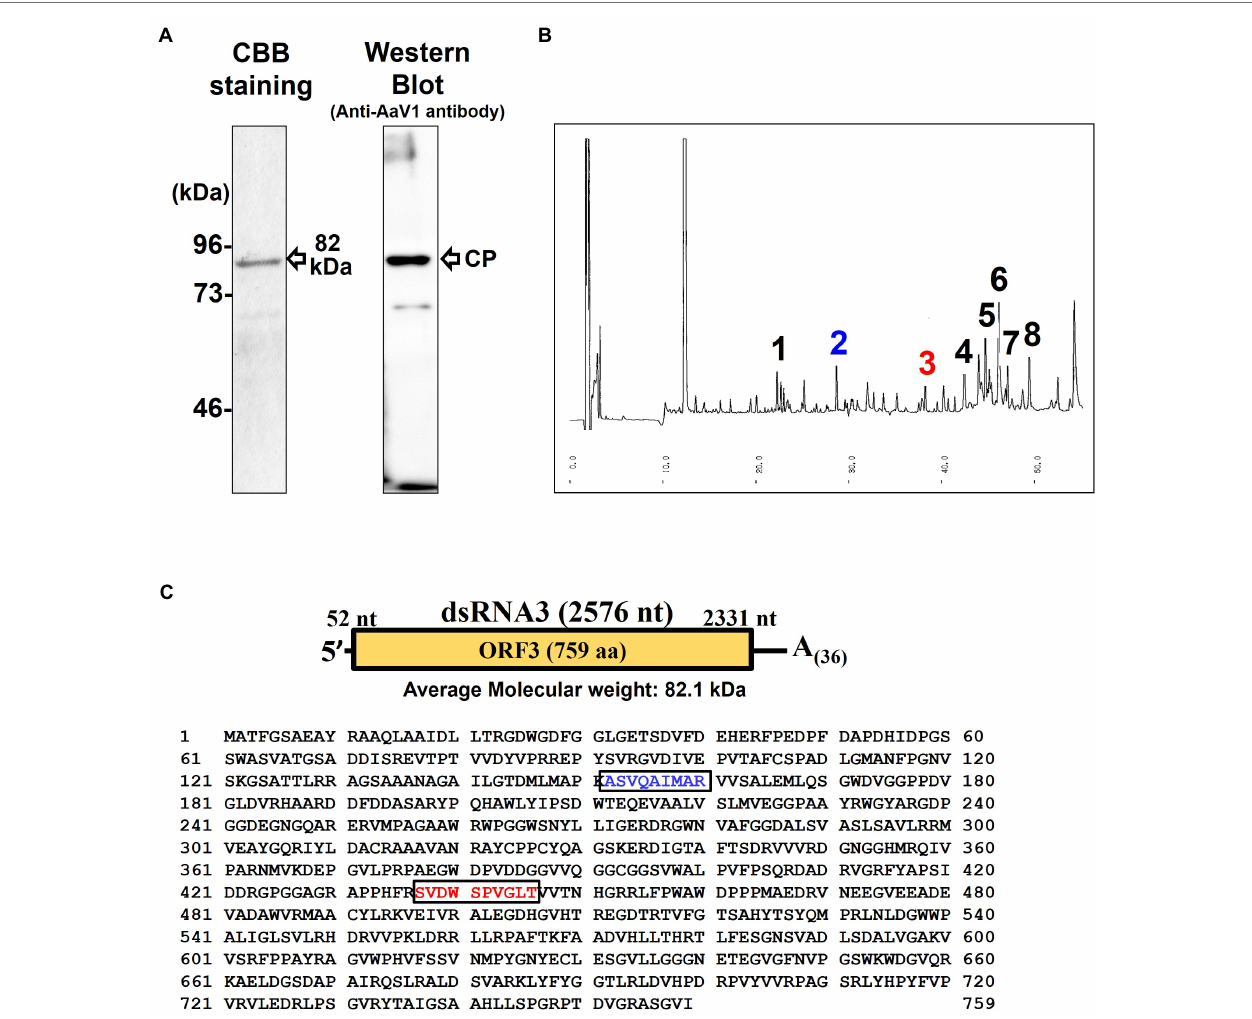
FIGURE 3 | Characterization of the AaV1 major coat protein. (A) SDS-PAGE and western blot of the purified AaV1 particles. Purified viral proteins from strain EGS 35–193-1d were stained with CBB (left) or immunoblotted with antiserum against the AaV1 virus particles (right). The arrows indicate the viral structural protein. (B) Reverse-phase HPLC of the 82 kDa major protein after digestion with Lysyl endopeptidase and trypsin. Peaks 2 and 3 were subjected to Edman degradation. (C) The deduced amino acid sequence of ORF3 (759 aa) written in one-letter code. The peptide sequences of peak 2 (blue) and peak 3 (red) were the same as the two regions in the predicted ORF3 peptide